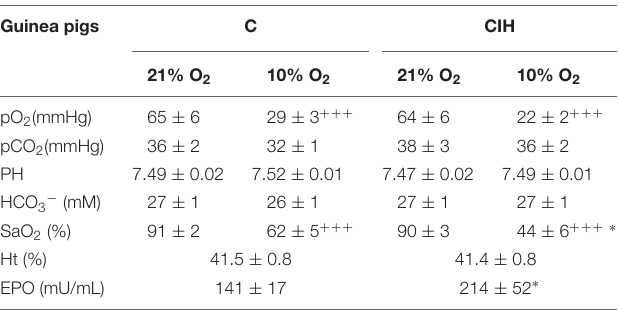
TABLE 1 | Arterial blood gasometry data, hematocrit and erythropoietin measurements in control and CIH guinea pigs breathing normoxia (21% O 2 ) or acute hypoxia (10% O 2